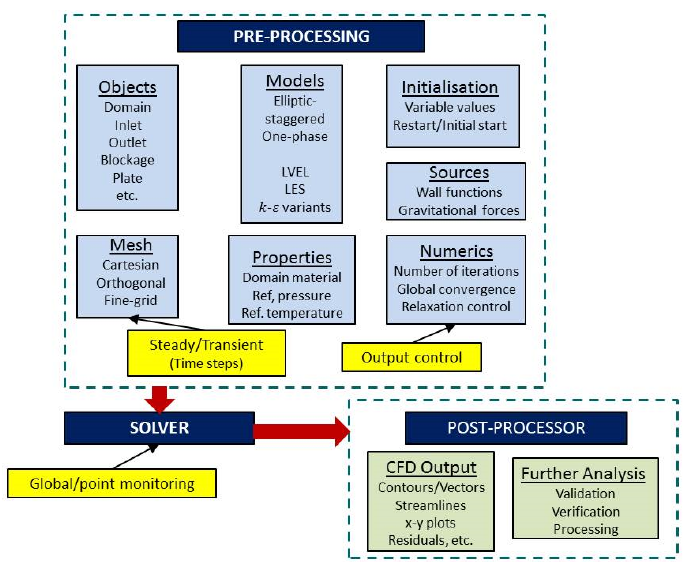
Figure 3. Summary of Computational Fluid Dynamics (CFD) interface. (Reproduced with permission from [24]).